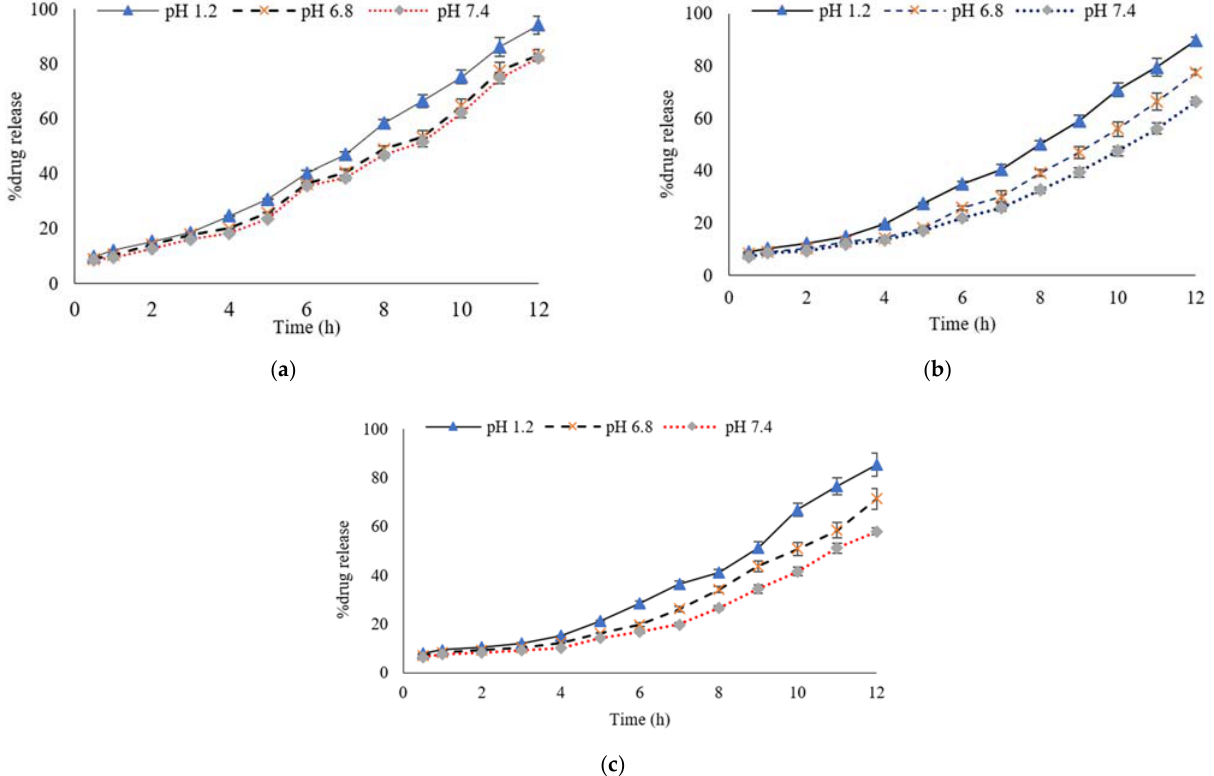
Figure 4. Percentage of MTX release profiles from Gel/PVA Hydrogel with polymer concentrations ( a ) GEL/PVA (9/2.5 g), ( b ) GEL/PVA (9/2 g), ( c ) GEL/PVA (9/1.5 g) at pH 1.2, pH 6.8 and pH 7.4 at 37 °C. Data are expressed as mean ± S.D. and p < 0.01 is considered statistically significant.